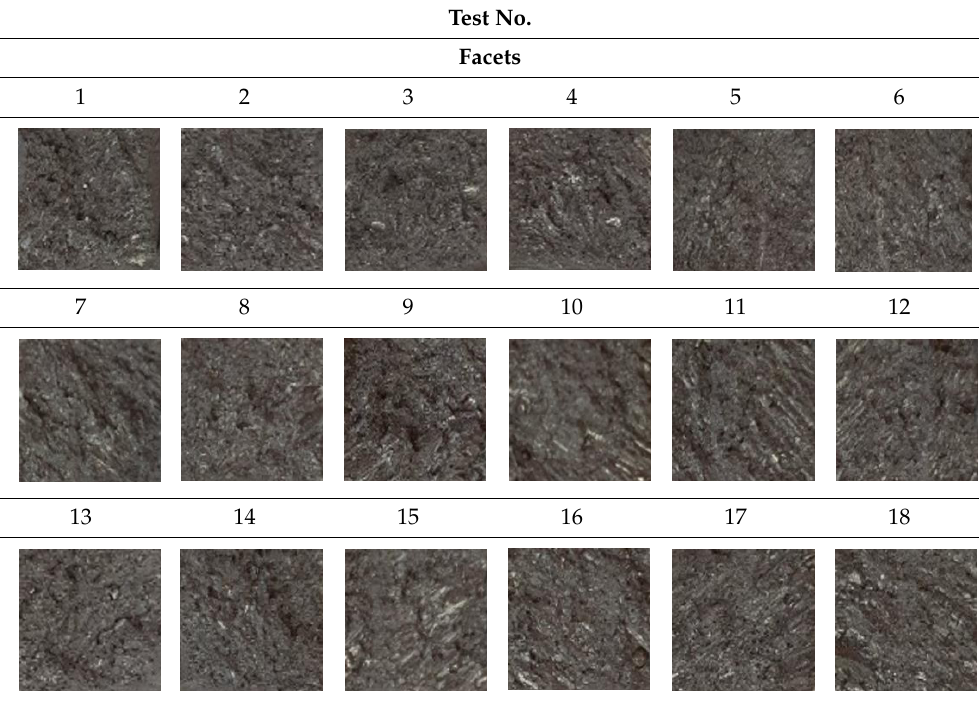
Table 6. Results of fracture geometry of the heat-affected zone according to the Charpy impact test.